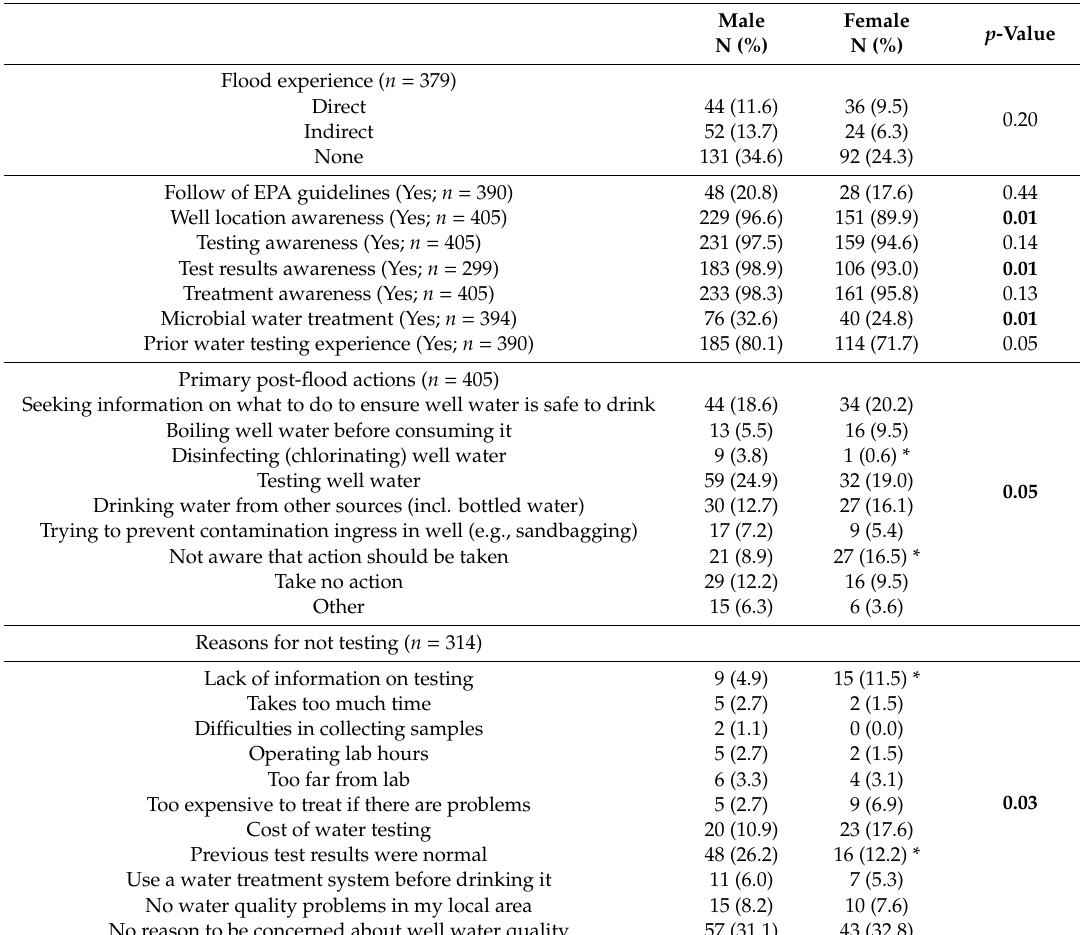
Table 4. Gender-related di ff erences in water treatment and testing awareness and post flood behaviours derived from Chi-square